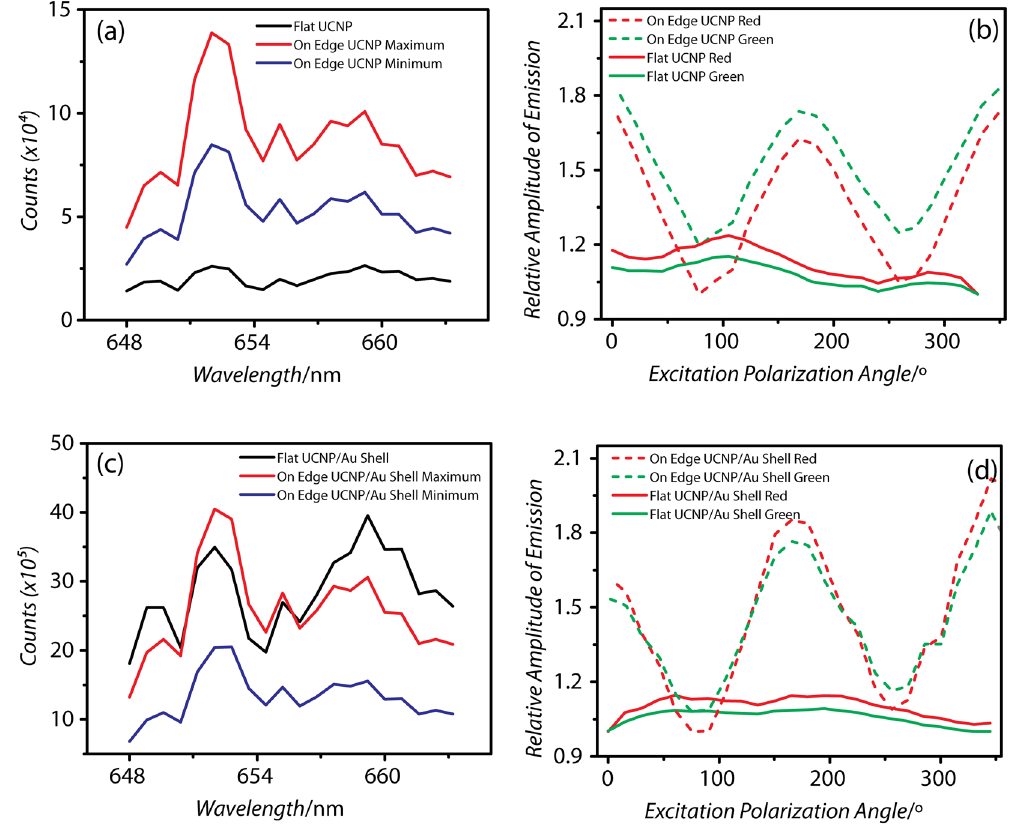
Figure 4. Red spectra ( λ = 650 nm) of ( a ) unmodified UCNP, ( c ) UCNP with 18 nm Au Shell, and the emission intensity dependence on the excitation polarization for ( b ) unmodified UCNP and ( d ) UCNP with an 18 nm Au shell plotted as a ratio to the lowest emission intensity polarization angle (I angle /I min ). Excitation intensity is 1.68e3 W/cm 2 and spectral measurement standard deviation is less than